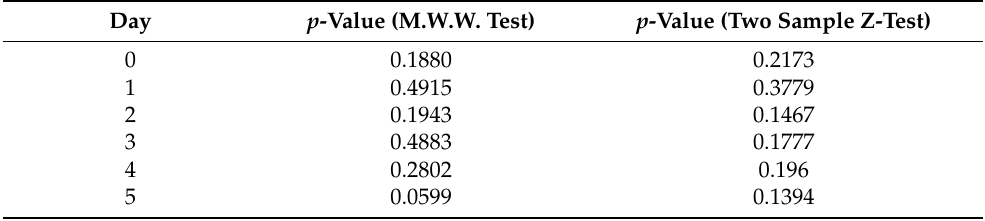
Table A5. Mann-Whitney-Wilcoxon test and the Two-Sample Z-test—Comparing Royal Dutch Shell and Exxon Mobil regarding the induced seismicity in the Netherlands ( df =